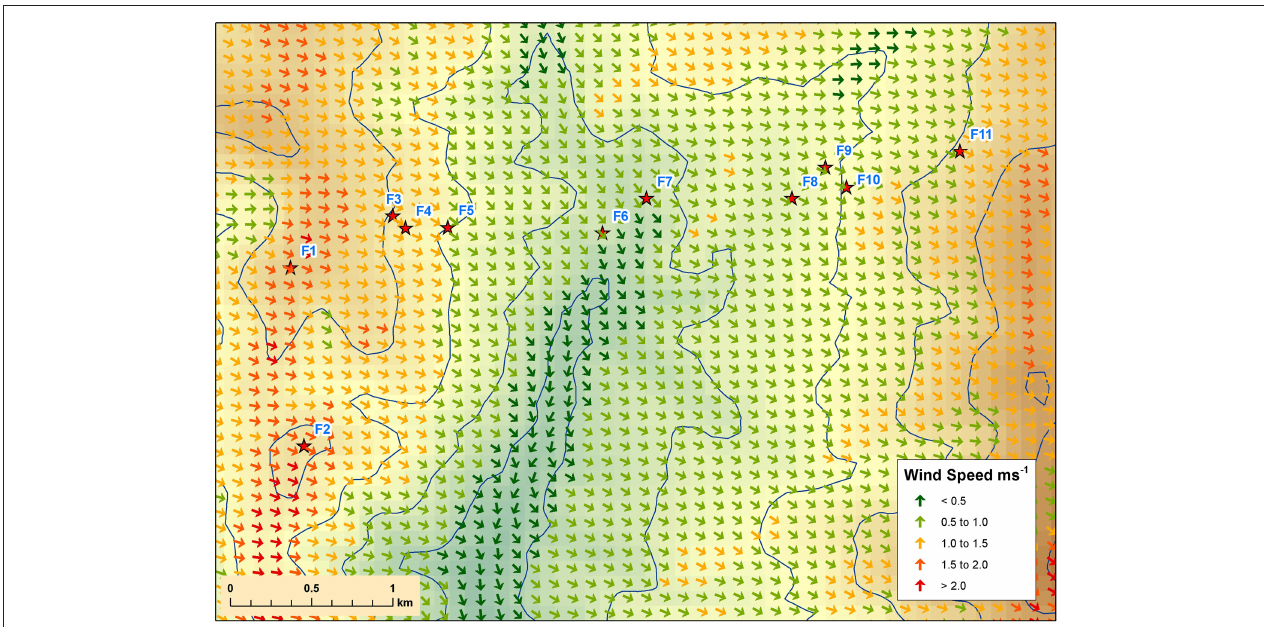
FIGURE 5 | WindNinja with native solver prediction over Flea Creek Valley, using domain-average wind speeds of 1 ms − 1 and domain-average wind direction of 252 ◦ .